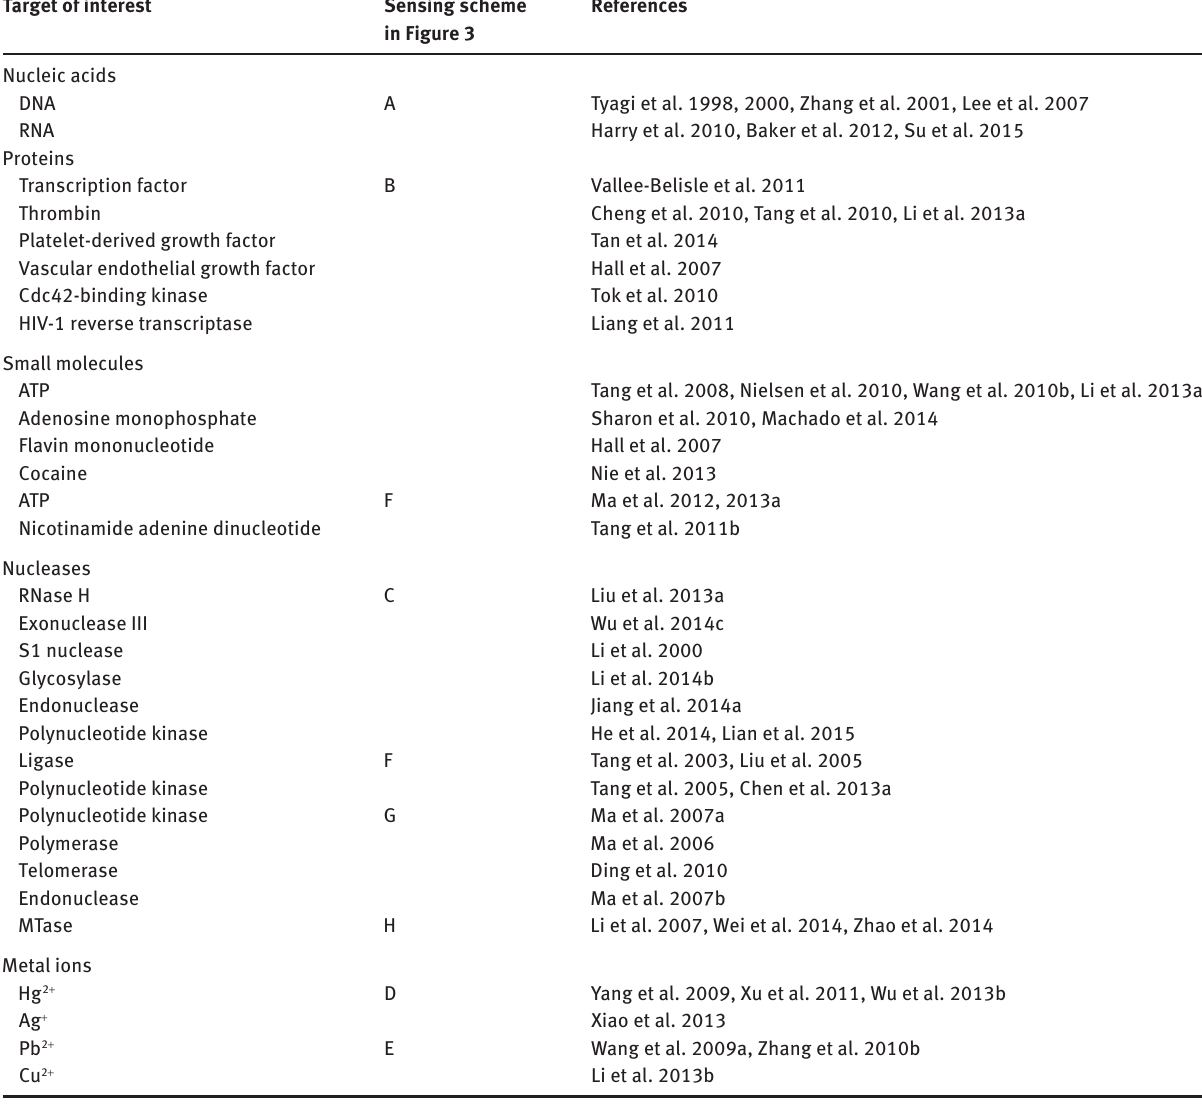
Table 2: MB-based “open-to-signal” schemes for sensing various targets. Target of